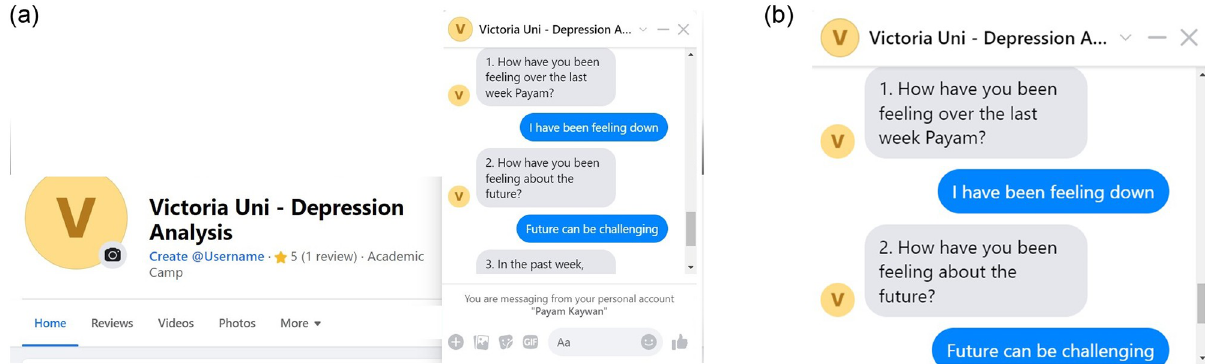
Fig 2. DEPRA in FB messenger and sample conversation with a participant. ( a ) Integration with Facebook Messenger. ( b ) Sample conversation between DEPRA and a participant.